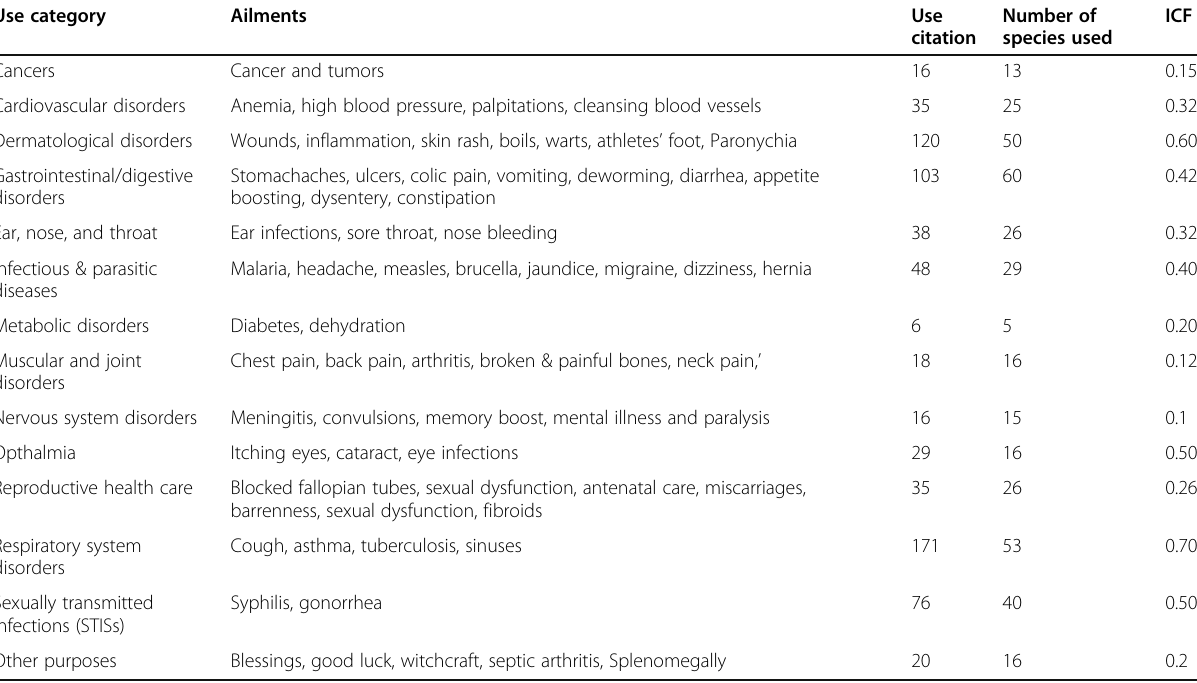
Table 3 Ailment categories treated by different medicinal plants Use